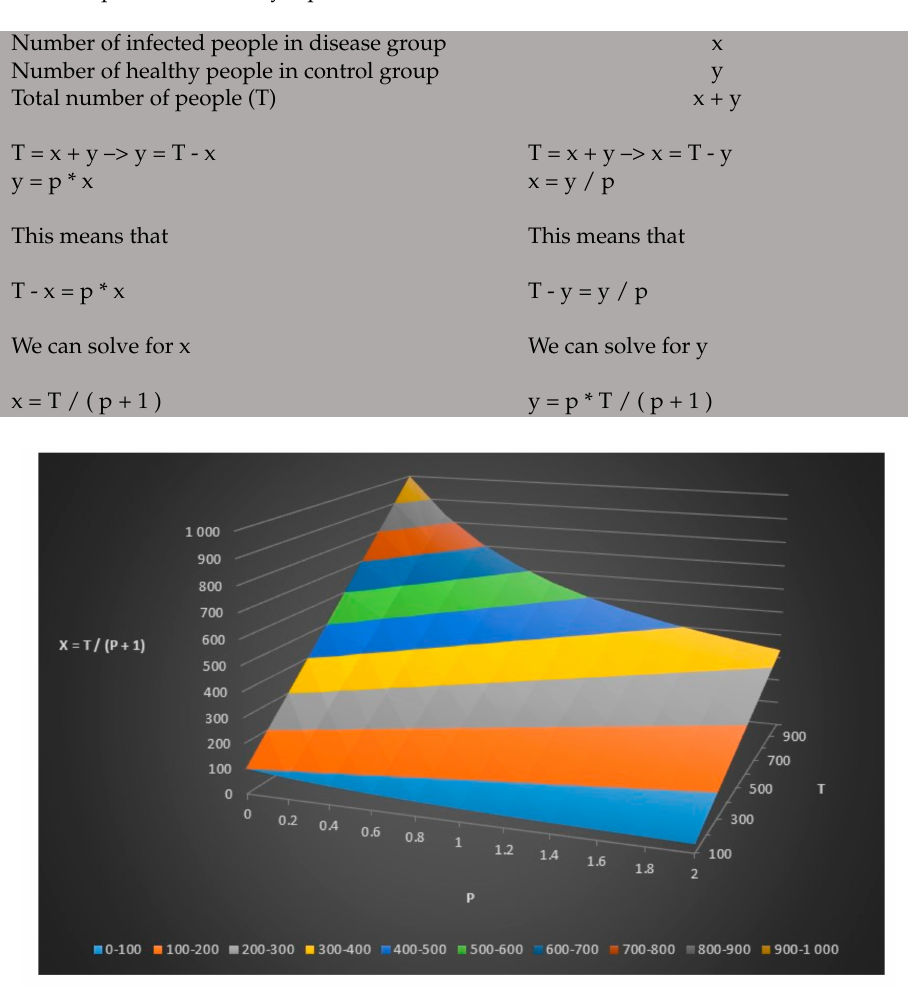
Figure 6. The number of infected people in the disease group (x) given total number of people (T) and the relationship (p) between x and